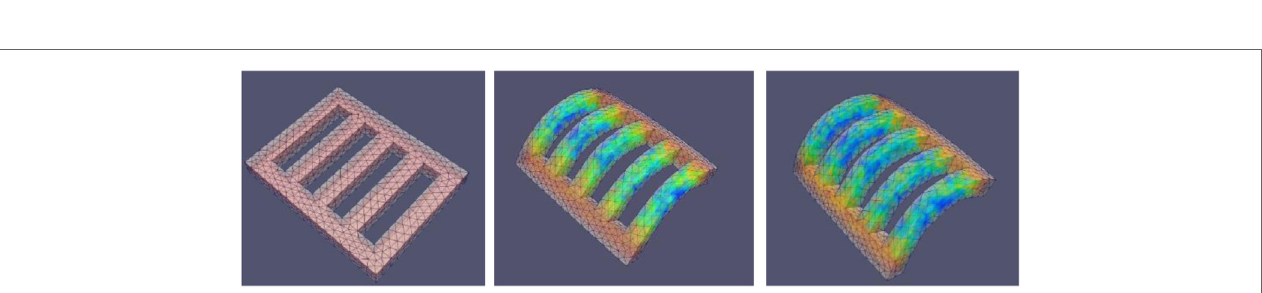
FigUre 4 | left: structure of a − 4 defect . Center: finite element simulation of an LCE disk with a − 4 defect, shape transformation on heating, heated initially from above. Right: if heated uniformly, each region of positive Gaussian curvature may emerge either upward or downward, producing a complex, disordered final